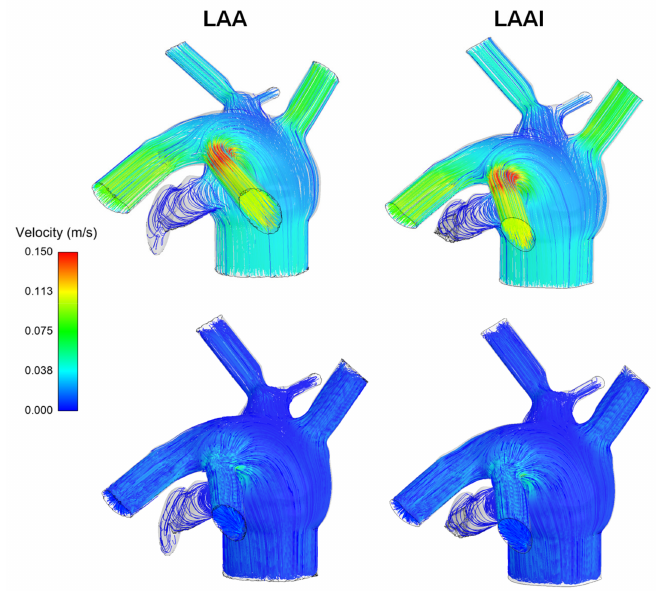
Figure 5. Flow velocity streamlines in the atrial chamber at peak systole of E-wave ( top row) and diastole ( bottom row) for both the non-inverted and inverted LAA.